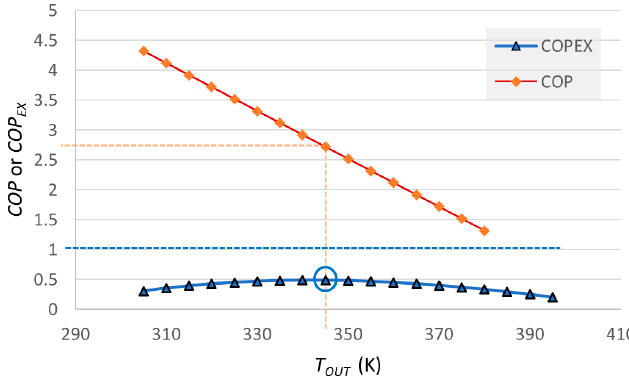
Figure 2 . Sample variation of COP and COP E X with a = 5, b = 0.04 K − 1 , T R = 288 K, T ref = 283K.